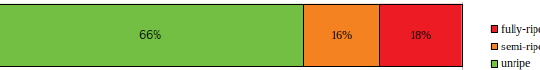
Figure 2. Proportions of classes of tomatOD